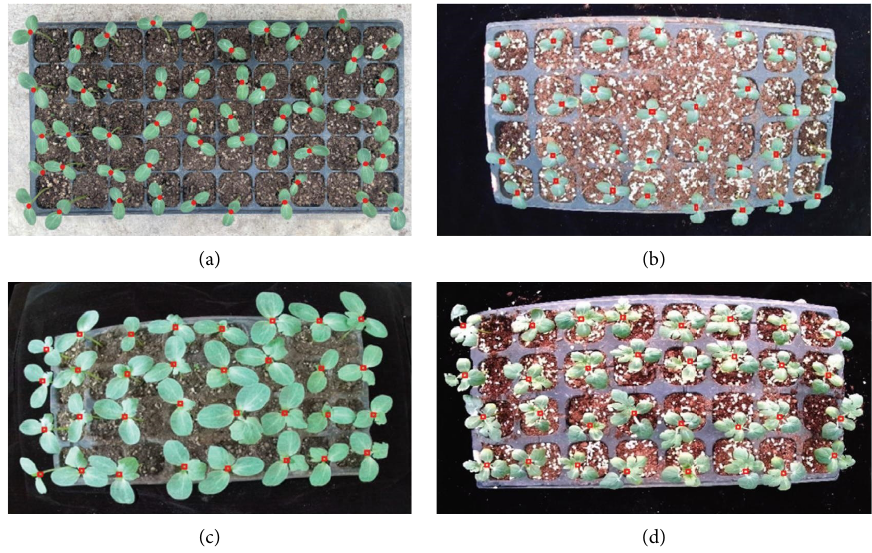
Figure 17: Growth point detection results. (a) Watermelon seedling detection chart at the young seedling stage. (b) One-true leaf and one- apical bud watermelon seedling detection. (c) One-true leaf and one-apical bud pumpkin seedling detection. (d) Two-true leaf and one- apical bud pumpkin seedlings detection. One-true leaf and one-apical bud pumpkin seedling